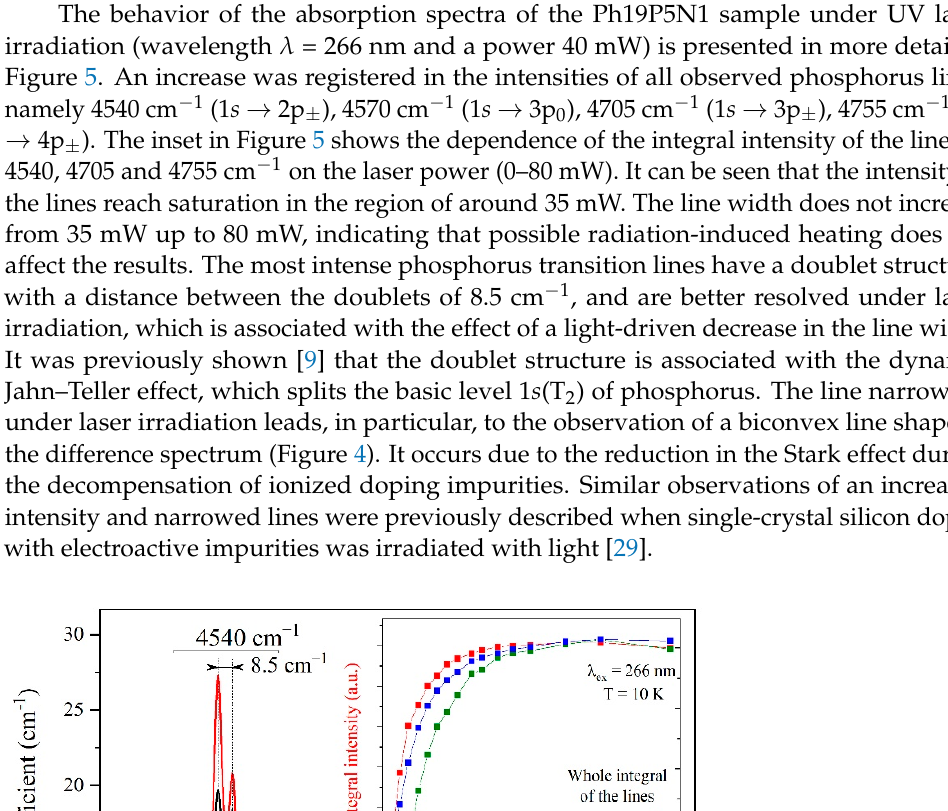
Figure 6. ( a ) Absorption band of phosphorus (4540 cm − 1 ) decomposed into contours in the Ph19P5N1 sample under irradiation by UV laser with a wavelength of λ = 266 nm and a power of 40 mW; ( b ) characteristics of 4539 cm − 1 individual contour line (intensity, width), depending on the laser radiation power.